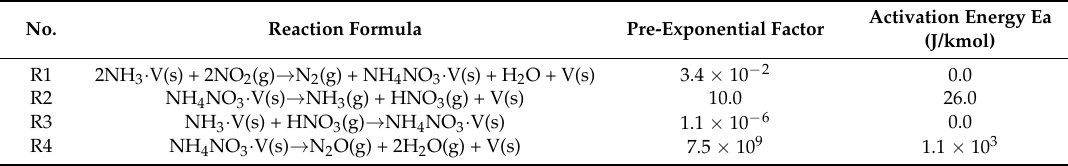
Table 5. Nitrate passivation reaction